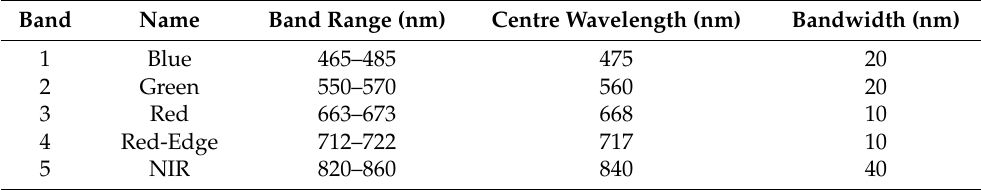
Table 2. Spectral characteristics of the five MicaSense